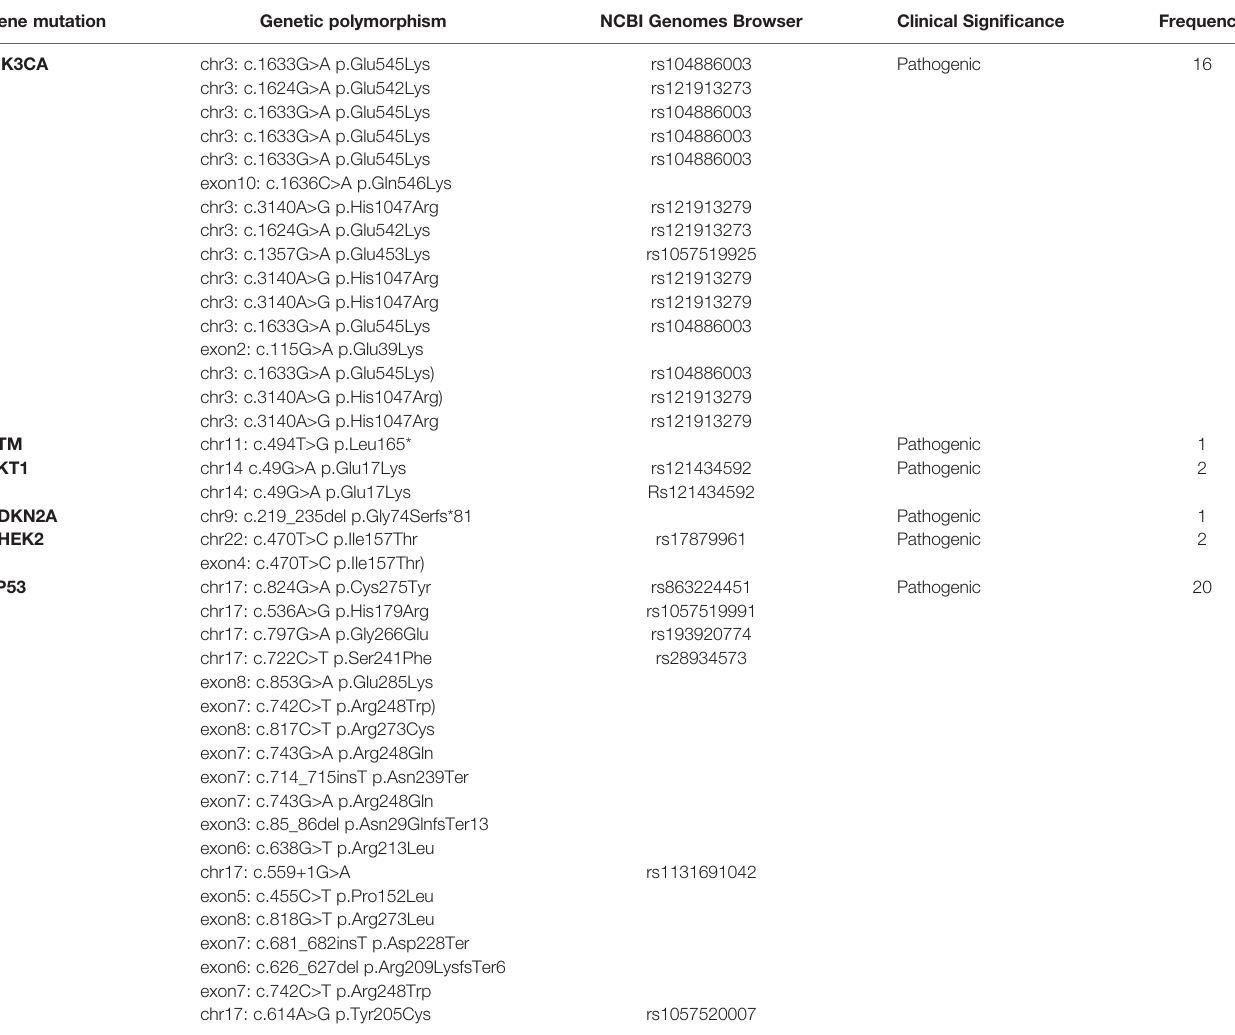
TABLE 8 | Somatic pathogenic mutations of old patients (>40 years) with breast cancer as determined by NGS